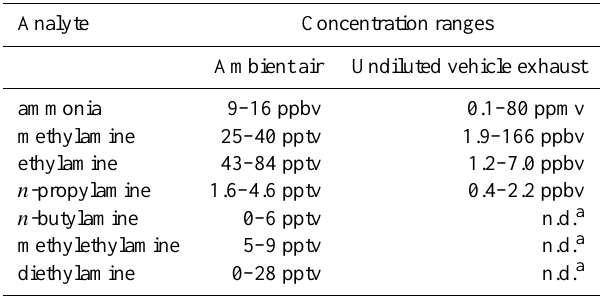
Table 5. Measured amine concentration ranges from ambient air and vehicle exhaust field